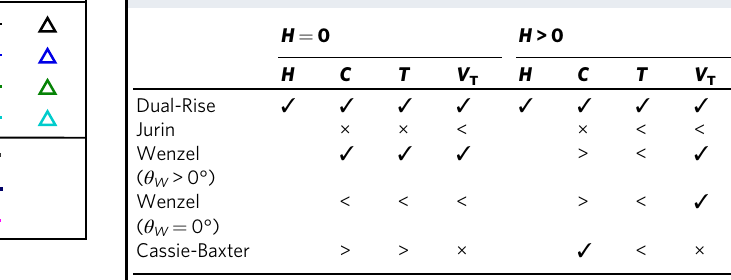
Table 3 Summary of model accuracies for hemiwicking H , capillary rise C , total liquid height T , and total volume V T .